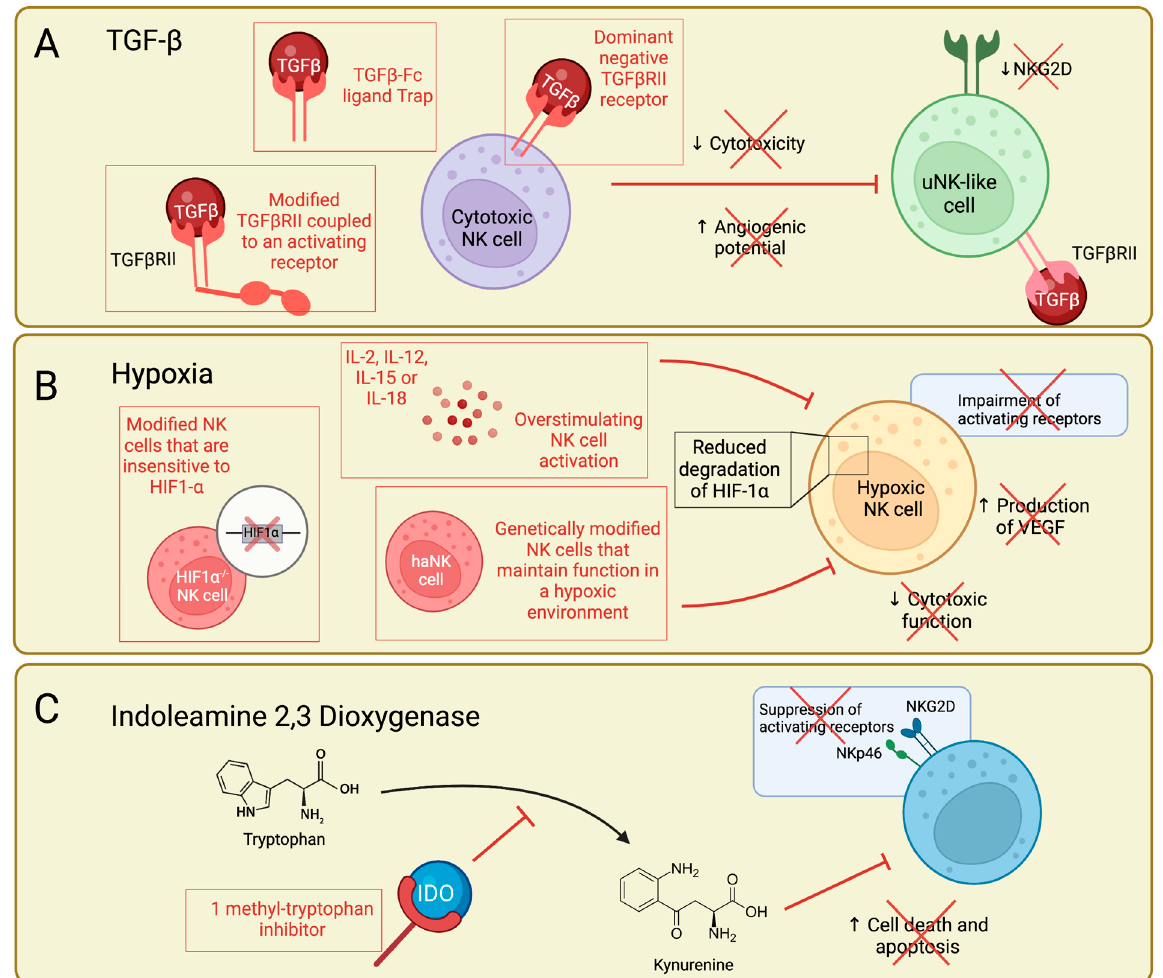
Figure 3. Current interventions targeting NK cell suppressive factors. NK cell suppression via ( A ) TGF β , ( B ) hypoxia, or ( C ) IDO. Figure created with BioRender